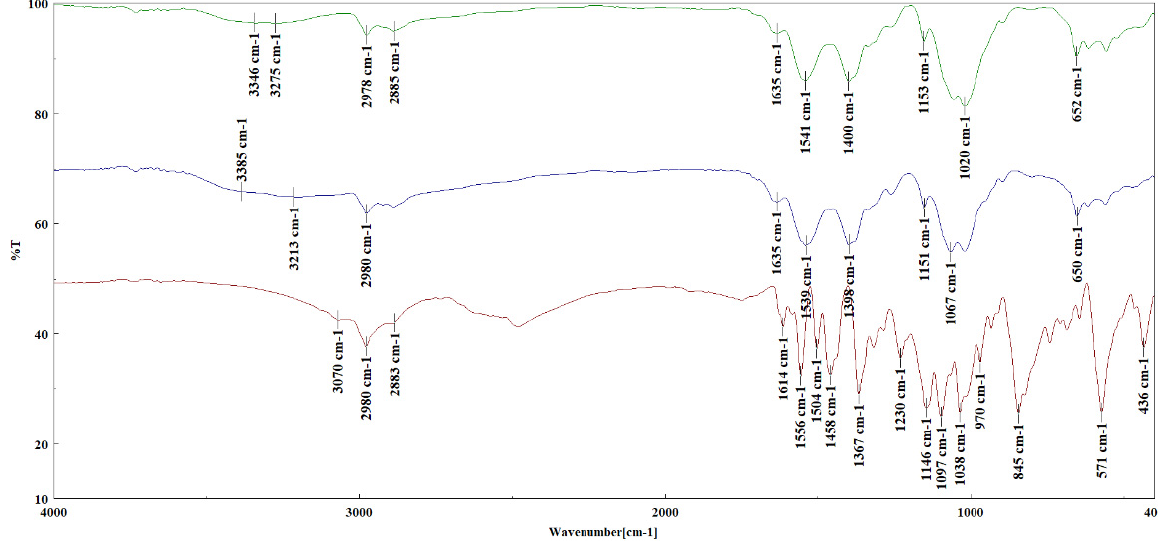
Figure 4. FT-IR spectra of chitosan–cellulose–dye (green), chitosan–cellulose (blue), and dye (red).